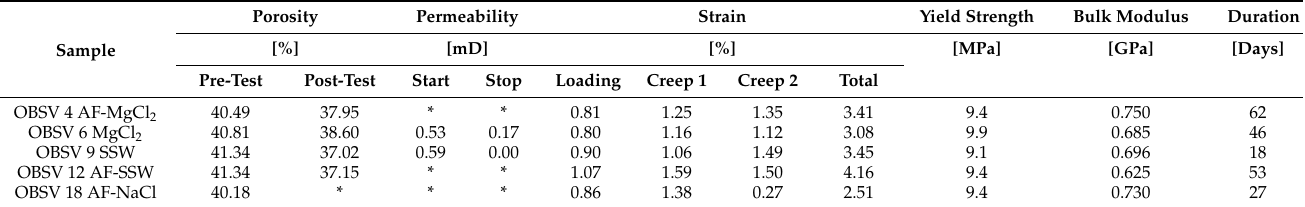
Figure 1. Selected samples and associated fluid composition versus flooding condition (artificial fractured cores have small holes in the center). Flooding direction indicates slice one being the so-called “inlet” followed by slice two, etc., until slice six, which is named the “outlet”. Table 2. The table distributes porosity, permeability, strain, yield strength, bulk modulus, and test duration. * No data available